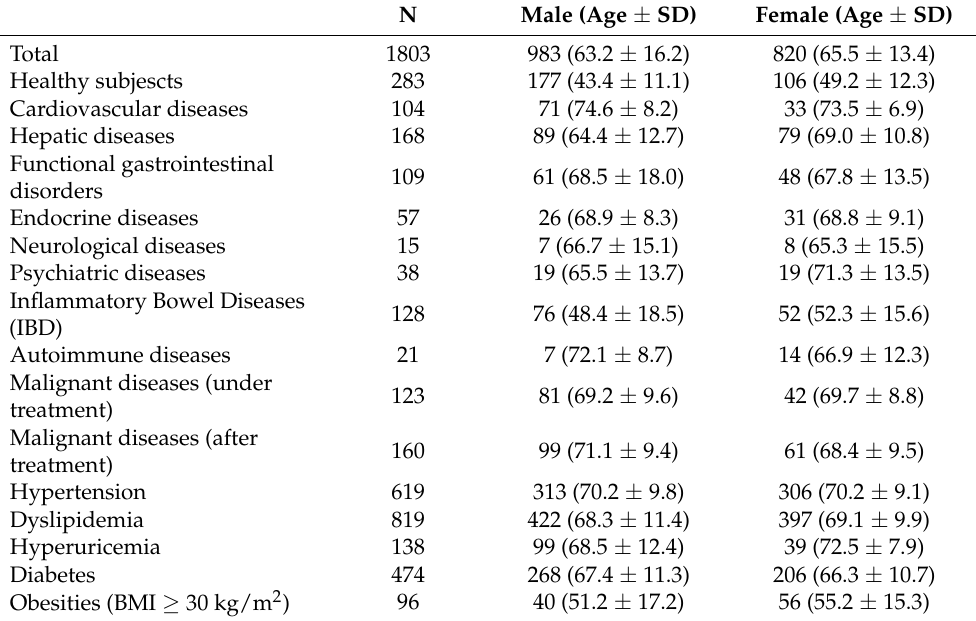
Table 1. Distribution of the enrolled study